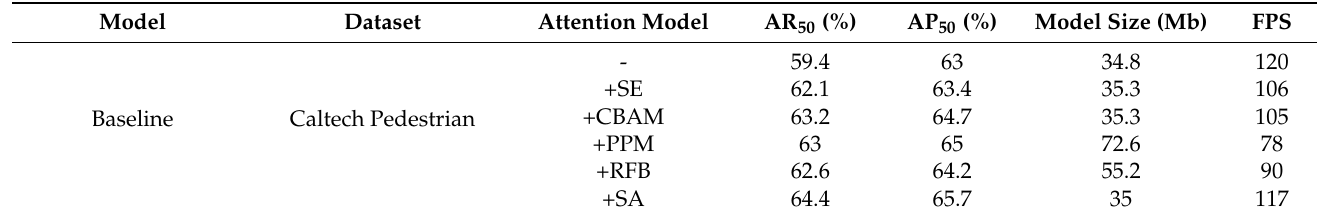
Table 4. Comparative experiments on attention mechanisms for Caltech detection